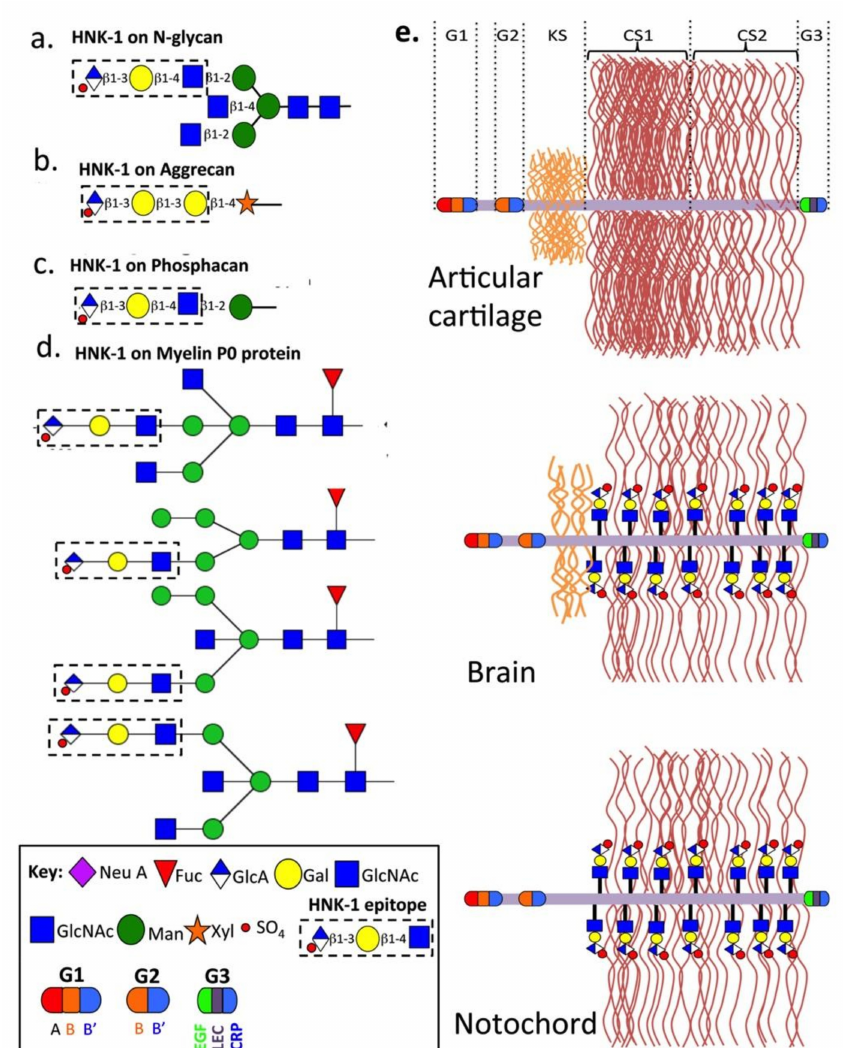
Figure 3. Structure of human natural killer-1 epitope (HNK-1) present on: N-glycans ( a ); notochordal aggrecan ( b ); brain phosphacan ( c ); and myelin Po glycoprotein in nervous tissues ( d ). Schematic depictions of representative aggrecan structures in articular cartilage, brain perineuronal nets and notochord in embryonic developmental tissues showing their variable relative KS contents and the presence of HNK-1 carbohydrate substitution in brain and notochordal aggrecan ( e